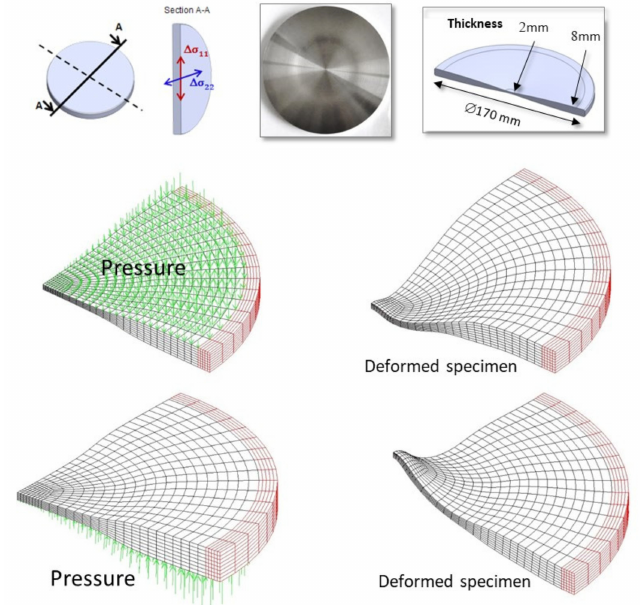
Figure 1. Principle of the equibiaxial fatigue test.